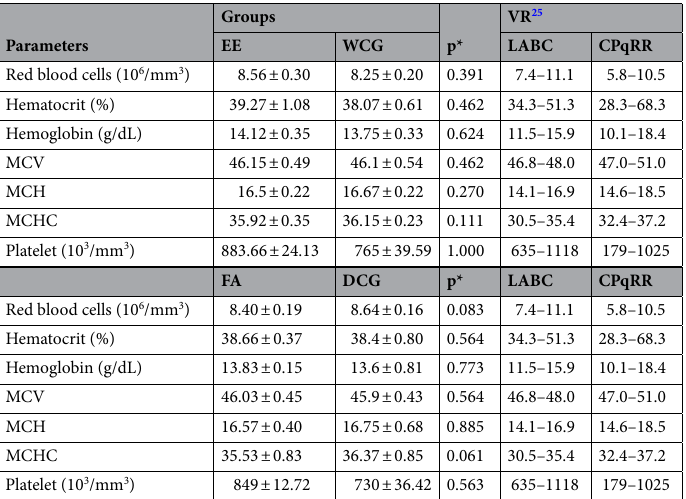
Table 6. Erythrogram and platelet count of mice treated with repeated doses of ethanolic extract or alkaloid fraction from Aspidosperma nitidum. EE ethanolic extract, FA fraction of alkaloids, WCG water control group, DCG DMSO control group (99% water + 1% DMSO), RV reference value, LABC Laboratory Animal Breeding Center, CPqRR René Rachou Research Center. * p value was obtained by Student’s T-test, comparing EE versus WCG, or FA versus